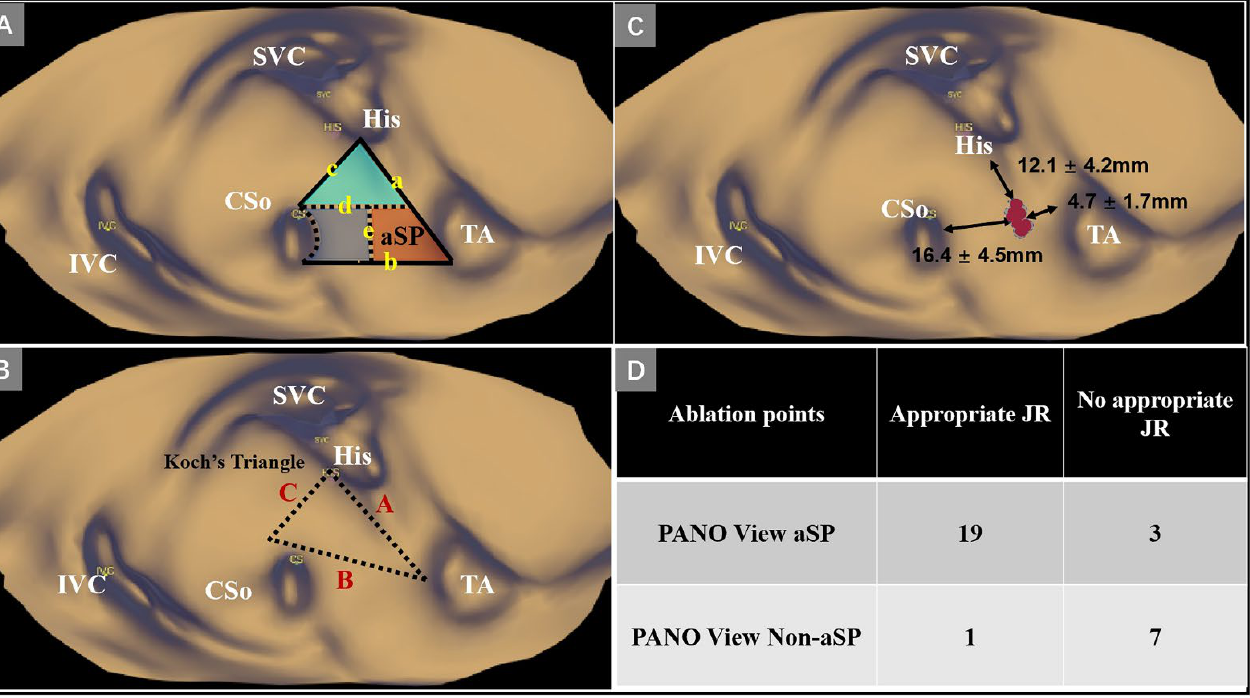
Figure 2. Ablation point distributions of the retrospective part. ( A ) Schematic view of the para-SP region. The para-SP region was divided into three distinct regions, which served as location sites for target distribution; a = closed line segment bound by the proximal His electrogramand tangential to the attachment line of the septal tricuspid leaflet; b = closed line segment bounded by the lowest point of the CS ostium and tangential to the CS; c = closed line segment bounded by the proximal His electrogramand the highest point of the CS ostium; d = closed line segment bounded by the highest point of the CS ostium and tangential to the CS; e = closed line segment bounded by the middle of the b and vertical to b; ( B ): Schematic view of the triangle of Koch. A = the anterior edge; B = the basal edge; C = the posterior edge; ( C ) Schematic view of effective ablation point distribution. Red dots represent ablation points; ( D ) Descriptive analysis of ablation point distribution. aSP = adaptive slow-pathway; CSo = coronary sinus ostium; His = His bundleelectrogram; IVC = inferior vena cava; JR = junctional rhythm; PANO View = Panoramic View; SVC = superior vena cava; TA = tricuspid annulus.